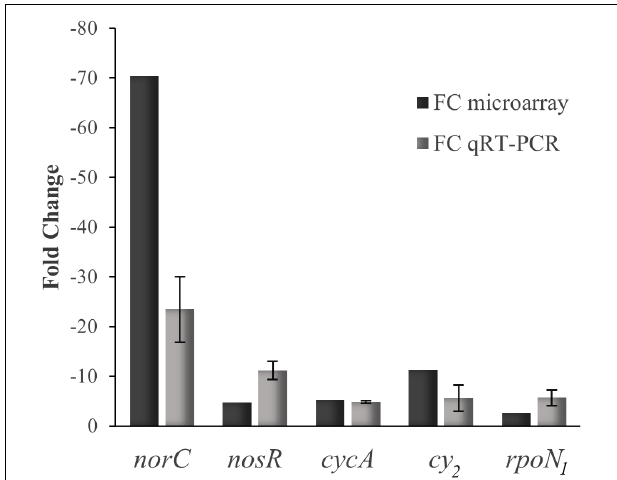
FIGURE 2 | Expression data of selected genes determined by microarray (black bars) and qRT-PCR (gray bars). Fold change (FC) refers to the relative expression of norC , nosR , cycA , cy 2 , norC , and rpoN 1 genes in the nnrR mutant in comparison with the WT, both cultured in anoxic denitrifying conditions. qRT-PCRs were performed with two independent experiments, each one with six parallel amplification